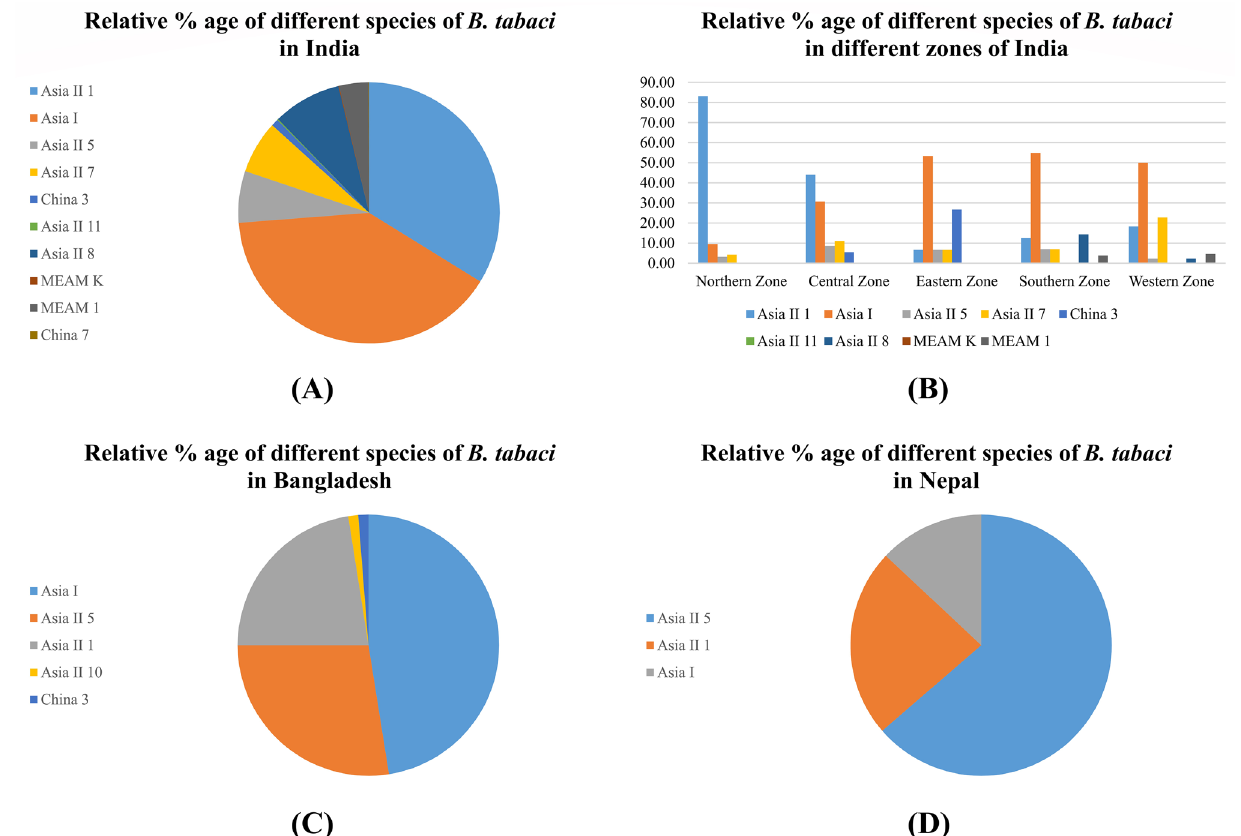
Figure 6. Distribution of different species of B. tabaci in other countries of South Asia. (A) The relative % of different species of B. tabaci so far reported from India. (B) The relative % of different species of B. tabaci from different zones of India. (C) The relative % of different species of B. tabaci from Bangladesh and (D) The relative % of different species of B. tabaci from Nepal.